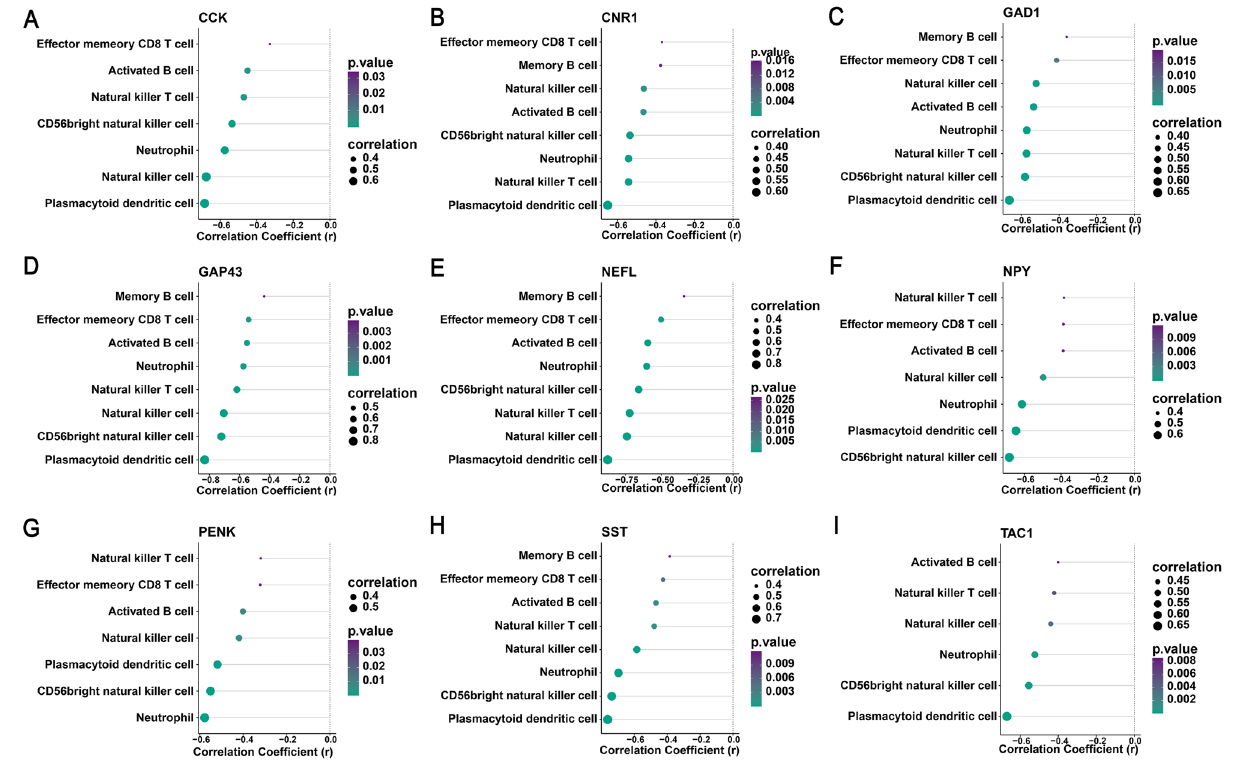
Figure 11. Correlation analysis between diagnostic genes and immune cells. Five hub genes including CNR1, GAD1, GAP43, NEFL, and SST, had significantly negative relationship with the differentially infiltrating immune cells including effector memeory CD8 T cell, activated B cell, memory B cell, natural killer cell, CD56 bright natural killer cell, natural killer T cell, plasmacytoid dendritic cell, and